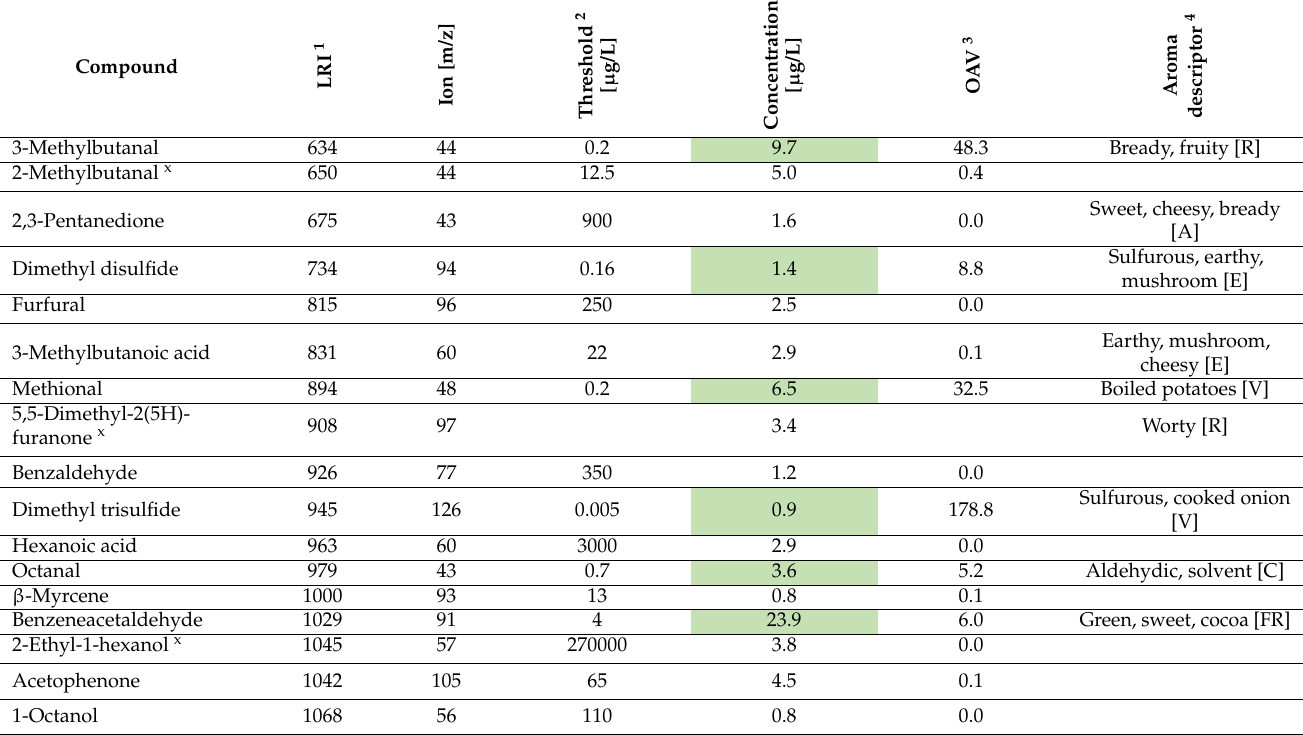
Table 2. The key aroma components of hopped wort used for the